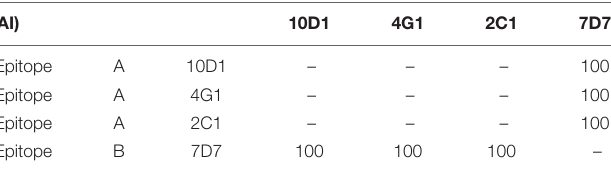
Frontiers in Microbiology |